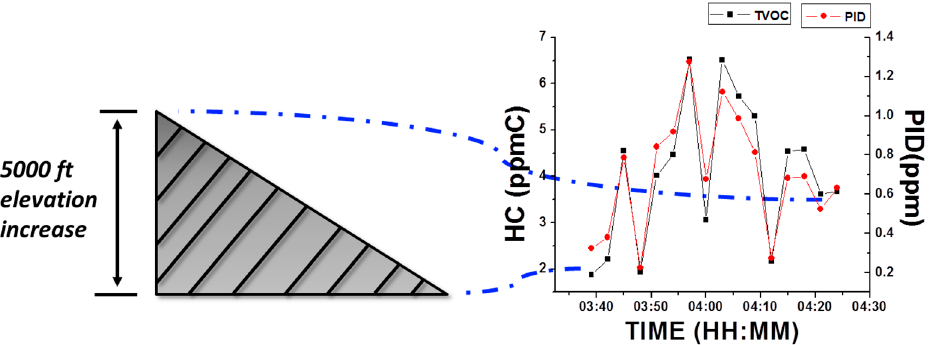
Figure 7. The new VOC device’s performance to a rapid elevation increase. Starting point and end point of the trip are indicated using dashed-dotted lines.